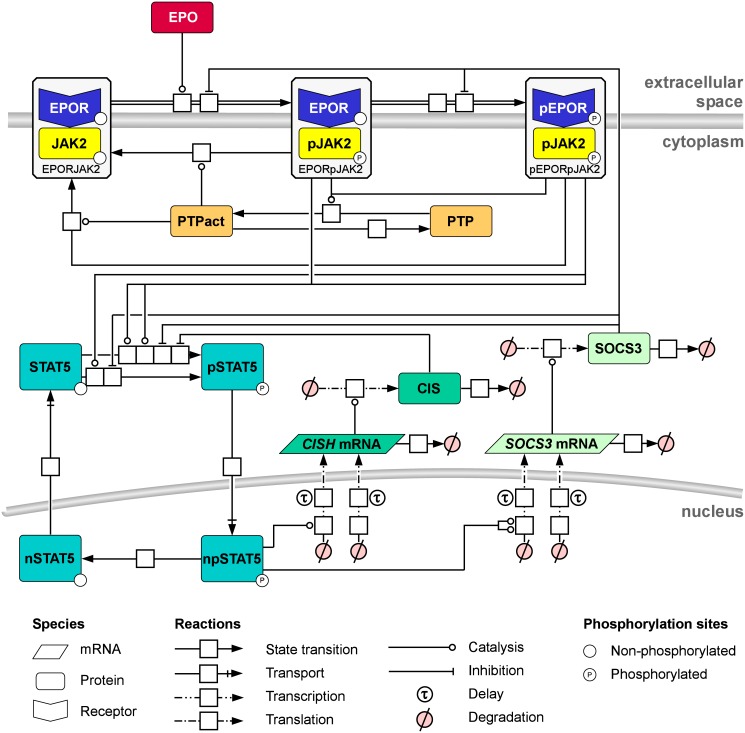
Generalized mathematical model structure of the EPO-induced JAK2/STAT5 signaling pathway.The process diagram of the EPO-induced JAK2/STAT5 signaling pathway model is shown according to Systems Biology Graphical Notation. The binding of the ligand EPO to its cognate receptor results in the phosphorylation of first JAK2 and then of the EPOR (pEPORpJAK2). STAT5 is recruited by pEPOR and phosphorylated by pJAK2 and translocates to the nucleus where it induces the transcription of the negative feedback regulators CISH mRNA and SOCS3 mRNA. Protein tyrosine phosphatase (PTP) regulates the dephosphorylation of the EPOR-JAK2 complex.